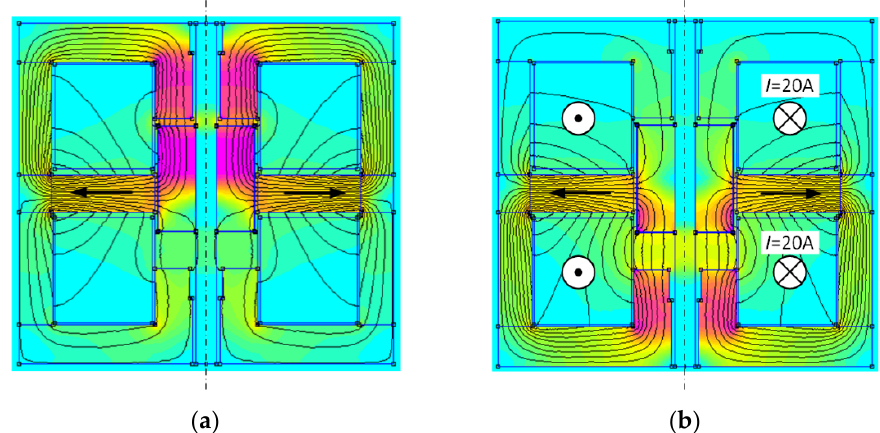
Figure 4. Magnetic flux density distribution in the longitudinal cross section for z = 0 and I = 20 A.